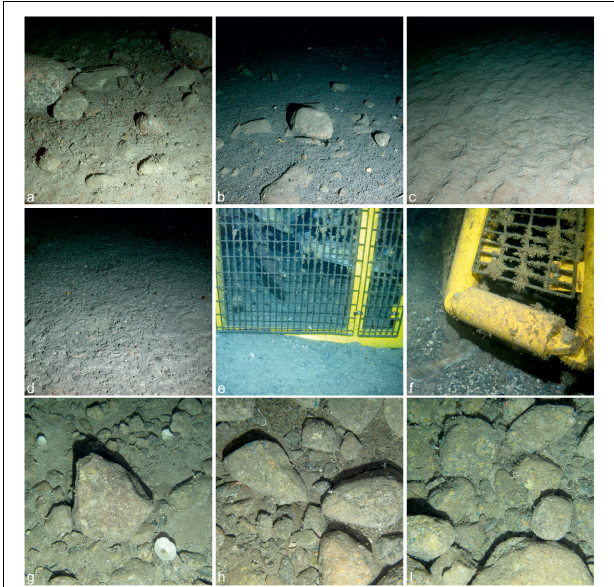
FIGURE 2 | Seabed environment and anthropogenic impacts surrounding Protective Structure A at Lancaster-205/21a-6; (a) undisturbed seabed with boulders, (b) boulders impacted by drill cuttings, (c) undisturbed coarse sand, (d) sand covered by drill cuttings, (e) base of the protective structure in contact with the seabed showing no scouring, (f) scoured sediment on the north west corner of the protective structure, (g–i) examples of background hard substratum from the 2011 environmental baseline survey, note Porifera in all images.